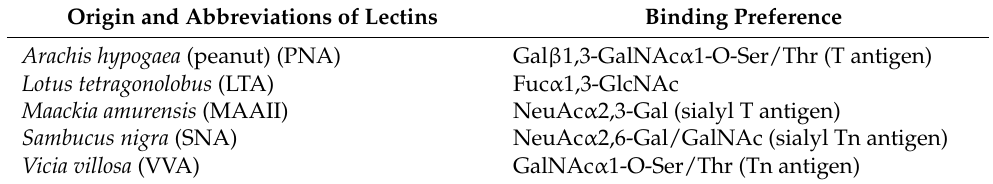
Table 1. Lectins used in ELISA tests.